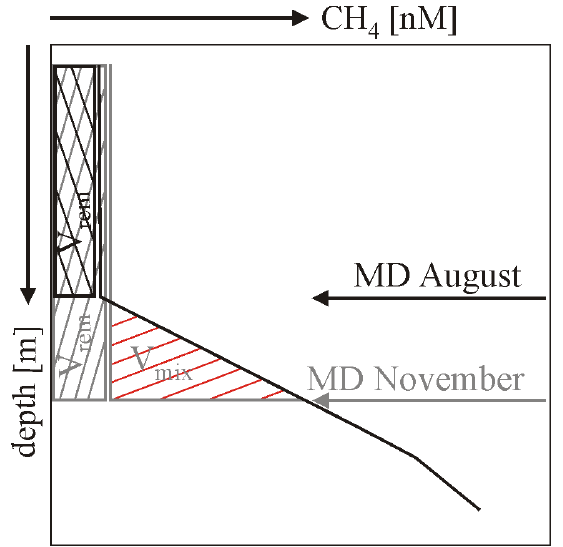
Fig. 10. Scheme illustrating a methane concentration profile (black solid line) in August and the deepening of the mixing depth (MD) from August (black arrow) to November (grey arrow). The amount of dissolved methane remaining in the homogeneous mixed upper water column V rem is estimated according to the surface methaneconcentrationmeasuredinAugustandNovember, respectively. Theamountofdissolvedmethane V mix is mixed into the upper water column during the period August till November.